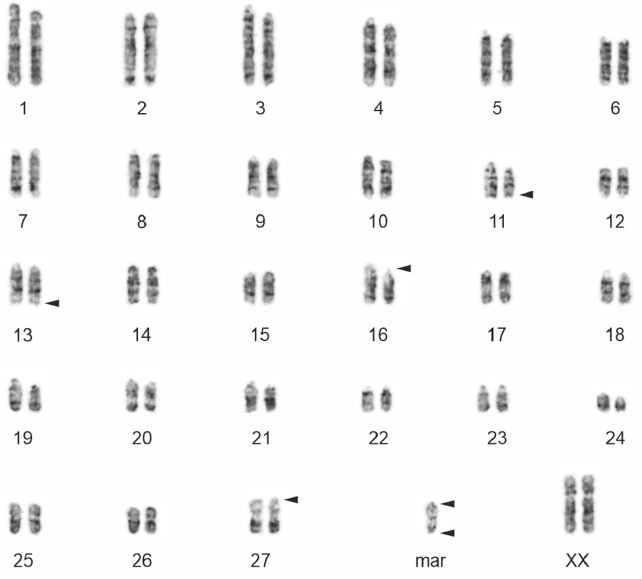
Figure 2. G-banded karyotype of Elephas maximus (2n = 57,XX,+mar). The chromosomes were arranged according to Yang et al. [19]. The arrowheads show the NOR Figure 2. G ‐ banded karyotype of Elephas maximus (2n = 57,XX,+mar). The chromosomes were ar ‐ ranged according to Yang et al. [19]. The arrowheads show the NOR positions.